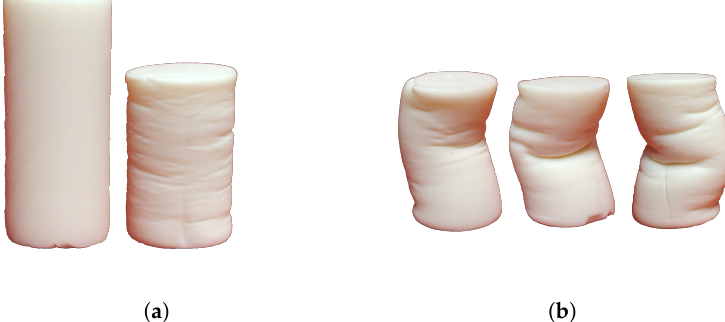
Figure 3. Deformation behavior of aerogel samples: ( a ) Initial and compressed sample with local buckling (wrinkling) effects, ( b ) Global buckling